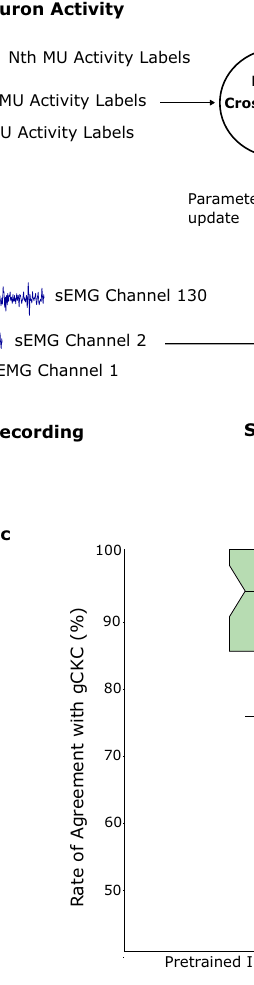
Fig. 5 | Results on the high-density EMG decomposition. a Decomposition of experimental high-density surface electromyography (HD-sEMG) recordings into underlying spinal motor neuron activities. The results obtained with the neural network (NN) were tested against the decomposition by a reference blind source separationmethodandmanualeditingbyanexpertoperator.MUstandsformotor unit. b Myoelectric digital twins were used to generate motor unitaction potential (MUAP) templates for different muscles and different model parameters (tissue conductivities, fi bre properties, tendon sizes, etc). 64 sets, each containing 5 simulated MUAPs for 130 electrodes, were used for pre-training. c Rate of agreement (%) between the neural network MU activity predictions and the